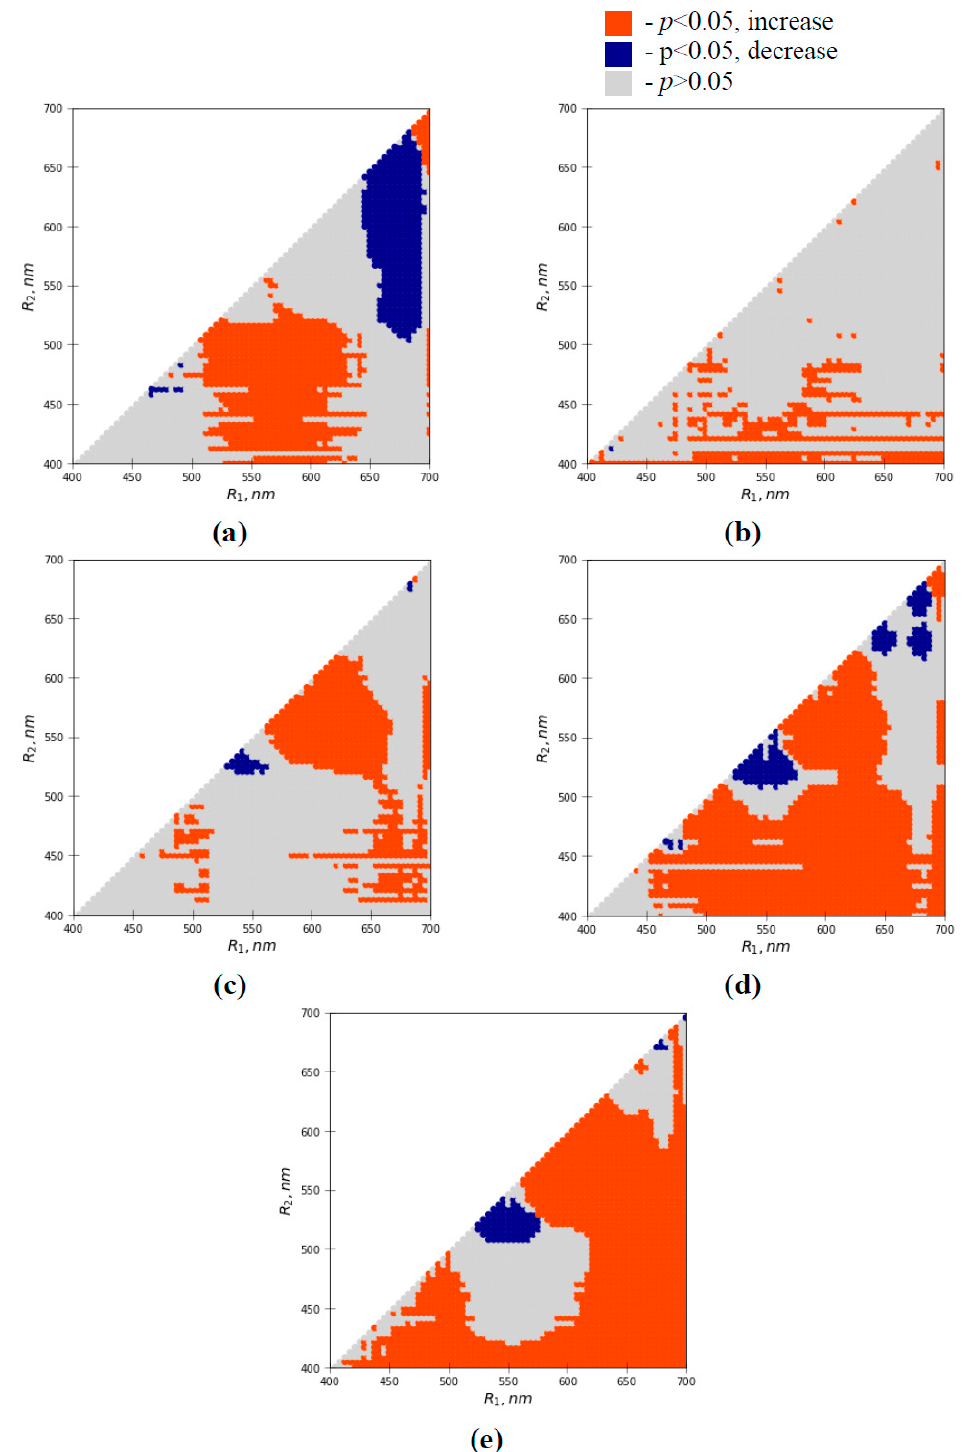
Figure 3. Heatmaps of significances and directions of water shortage-induced changes in absolute values of RIs in pea leaves in the first ( a ), second ( b ), third ( c ), fourth ( d ), and fifth ( e ) days of the water shortage. RIs were calculated based on ( R 1 ) − I ( R 2 ) equation RI = I , where I(R 1 ) and I(R 2 ) are intensities of reflected light at different narrow spectral bands (averaged I ( R 1 )+ I ( R 2 ) for 3 nm). The Mann–Whitney U test was used for p